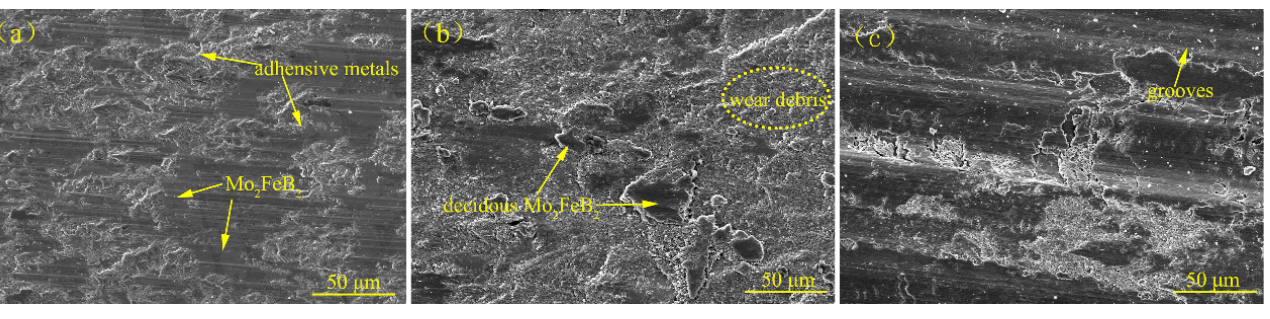
Figure 11. Wear morphology of claddings with different TiC contents and substrate. ( a ) 5% TiC, ( b ) 15% TiC and ( c ) Substrate.